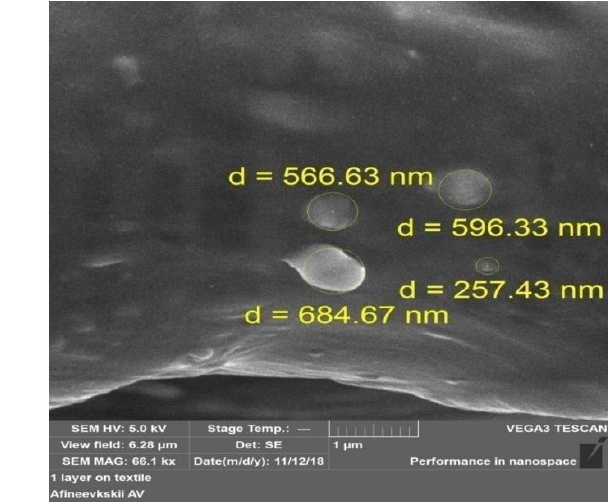
Figure 1. SEM photograph of textile material containing polyelectrolyte